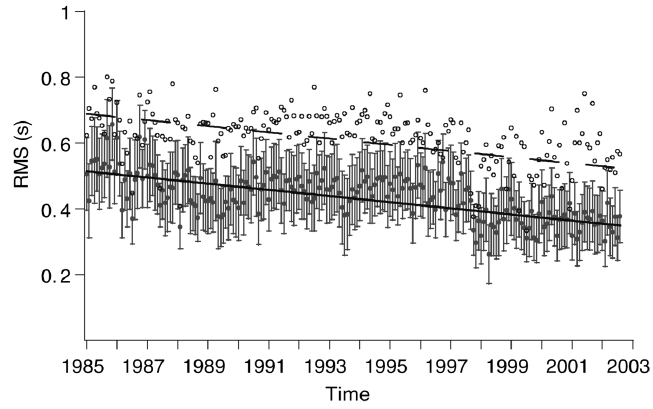
Fig. 5. Monthly averages (dots) of RMS travel time residuals and associated standard deviation (bars). The lines represent the linear fit of the RMS versus time. Open dots and dashed line pertain to magnitude M F 3.3 events, whereas closed dots and continuous line pertain to all the